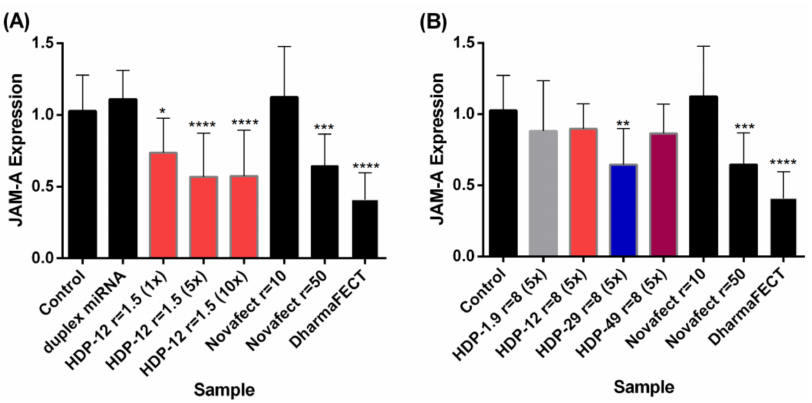
Figure 4. Transfection efficiency expressed as downregulation of JAM-A mRNA in MCF-7 cells: ( A ) complexes containing CS HDP-12 at (N/P) charge ratio = 1.5; and ( B ) complexes containing CS HDP-1.9, HDP-12, HDP-29 and HDP-49 at (N/P) charge ratio = 8. Duplex miRNA (dose 1 × = 0.05 nmol/well), DharmaFECT (5 µ L/well) and Novafect O 25 were used as controls. Data represent mean values ( ± SD) of three independent biological experiments and three technical replicates. Statistical comparisons were between each treatment and the control of untreated cells using non-parametric Kruskal–Wallis test (* p < 0.1; **; p < 0.01***; p < 0.001; **** p < 0.0001).